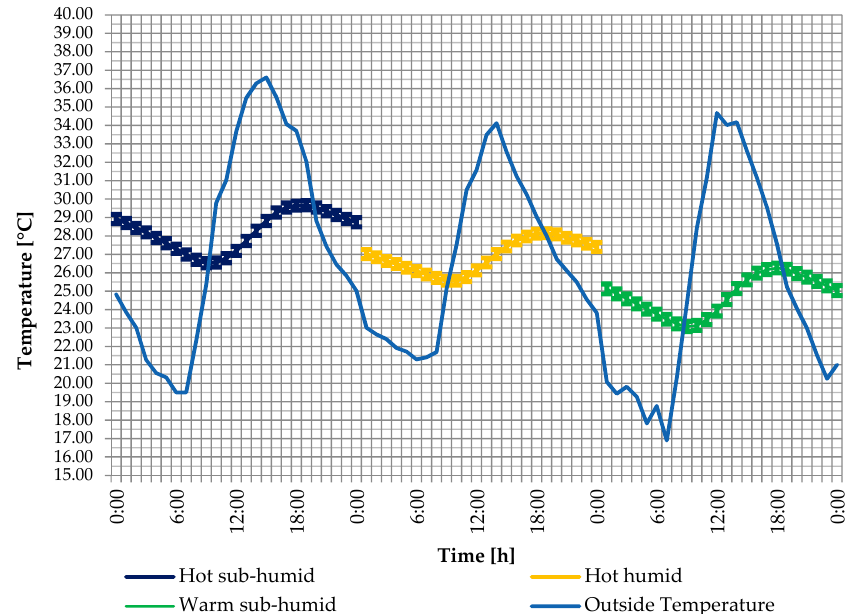
Figure 18. Representative day of the wet fabric performance in the three climatic conditions.